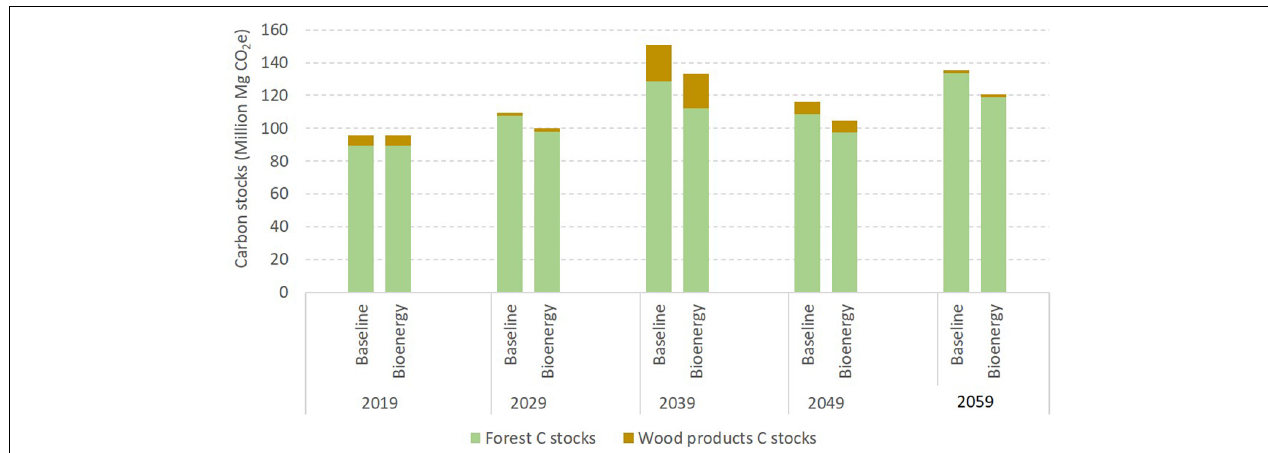
FIGURE 3 | Forest carbon stocks on NIPF pine plantations in the accumulated feedstock supply areas of the three Drax pellet mills under a baseline (no thinnings) and bioenergy scenario. Results are dominated by changes in forest carbon stocks. Forest and wood product carbon stocks for pellet mill specific supply areas follow a similar pattern (see Supplementary Figures 1–3